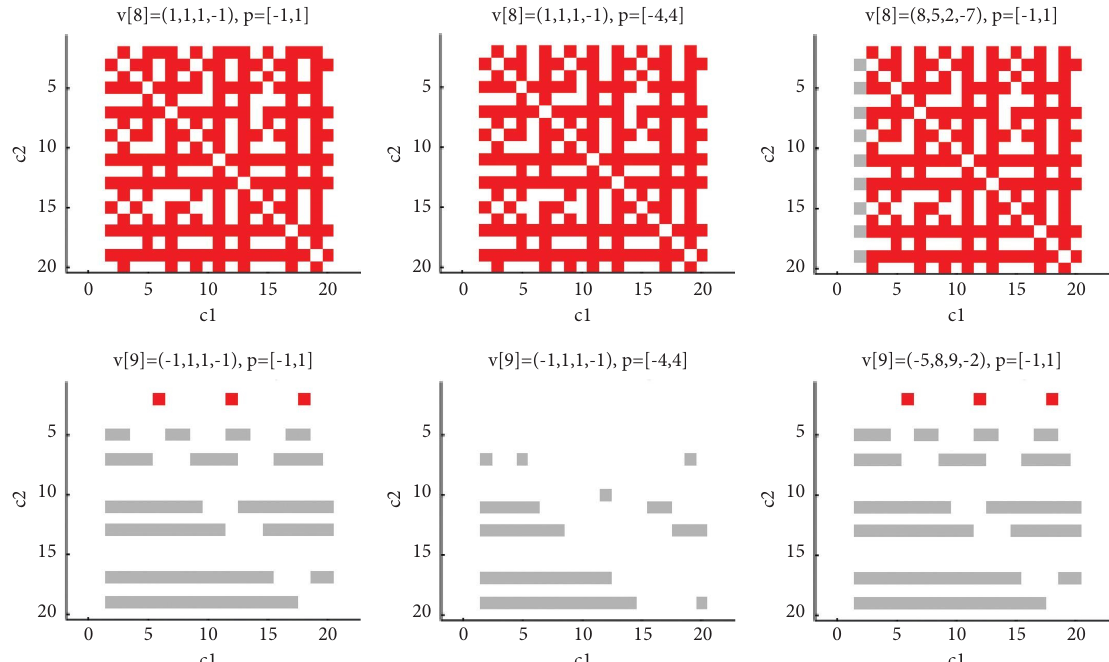
Figure 7: Attractors for tuples v and v from Proposition 4. Both tuples generate predator-prey interaction, with the species C 8 9 prey. For v , C does not depend on C (it may feed on other items), but C 8 1 2 ,c ) � 1. For v there is dependence between the prey and the predator: the species C gcd ( c 1 2 9 escape from C in order to survive. Local fxed points are those with prime c 1 ( c ,c ) < 0, so the species C F disappears. 1 1 2 1